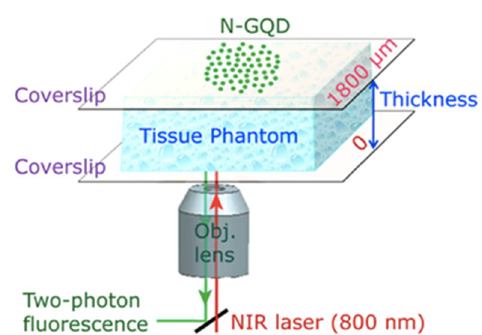
Figure 3. Schematic representation of the set‐up used for TPFI of N‐GQDs in tissue phantom with different thickness. TPFI is known for deep penetration into tissue with mitigated photo‐damage during application. TPFI of N‐GQD was analyzed using a NIR femtosecond laser as excitation and implemented for tissue imaging up to the penetration depth of 1800 µm. With negligible photo‐thermal effects of N‐GQDs, it was possible to use N‐GQDs in TPFI on living cells with strong fluorescence [139].